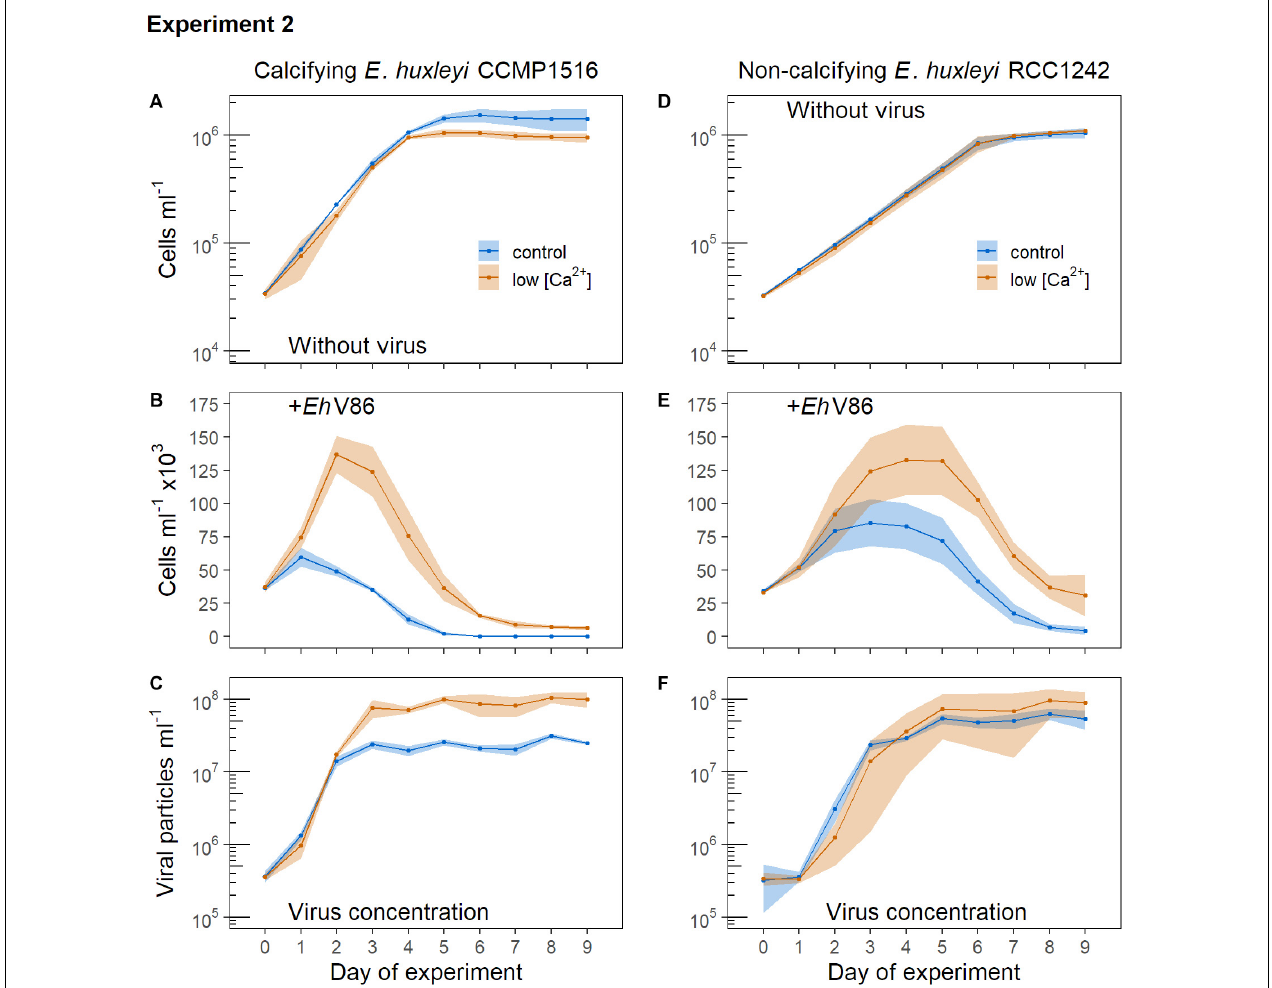
FIGURE 4 | Addition of virus to normal cells of E. huxleyi (controls = blue symbols) and to cells that were grown under low [Ca 2 + ] (red symbols). Virus was added at the beginning of the light period (12:12 h light-dark cycle). Symbols represent the sample means, ribbons the 95% confidence interval ( n = 3). (A) Concentration of calcifying E. huxleyi CCMP1516 without virus and (B) when virus was added; (C) concentration of viral particles. (D) Concentration of non-calcifying E. huxleyi RCC1242 without virus and (E) when virus was added; (F) concentration of viral